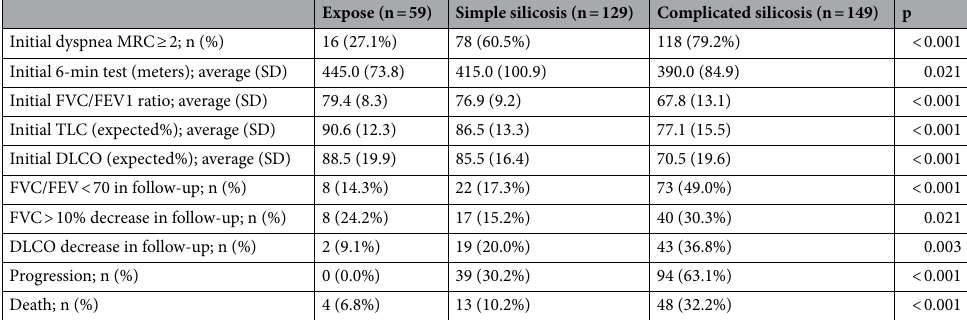
Table 2. Baseline clinical and lung function characteristics, change of lung function, and progression in patients. Statistical significance was determined using χ 2 test and ANOVA test for qualitative and continuous variables, respectively. *p < 0.05; **p < 0.001.